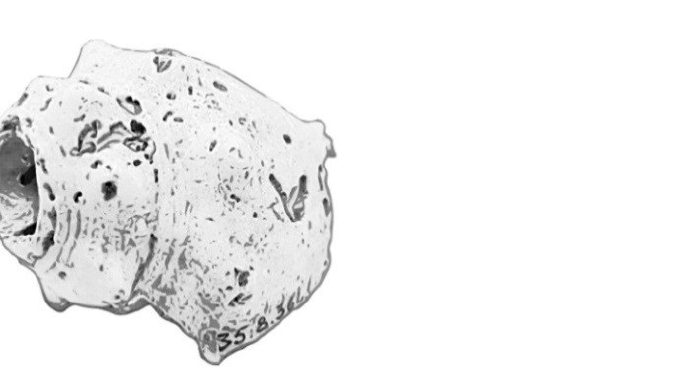
Figure 1. Stuccoed and painted shell horn made from Triplofusus princeps , Teotihuacan (MNA, Inv. 10-223548); length: 35.8 cm. All drawings of the sonic artefacts are created by the author and based on the photographic documentation made for the project.